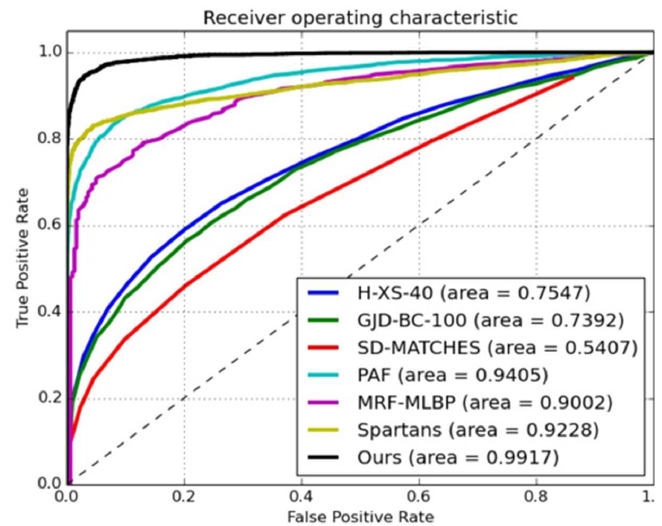
Figure 15. ROCs with different unsupervised models on LFW dataset.